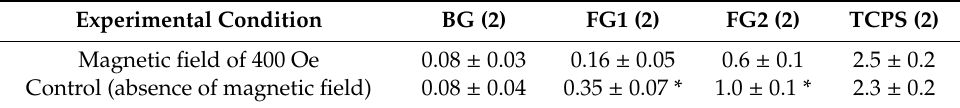
Table 3. The effect of a magnetic field on the fibroblasts population number doublings. Data are presented as X ± m , n = 54 (9 fields of view per well × 6 wells). A level of significance P < 0.05 was determined for FG1 and FG2.